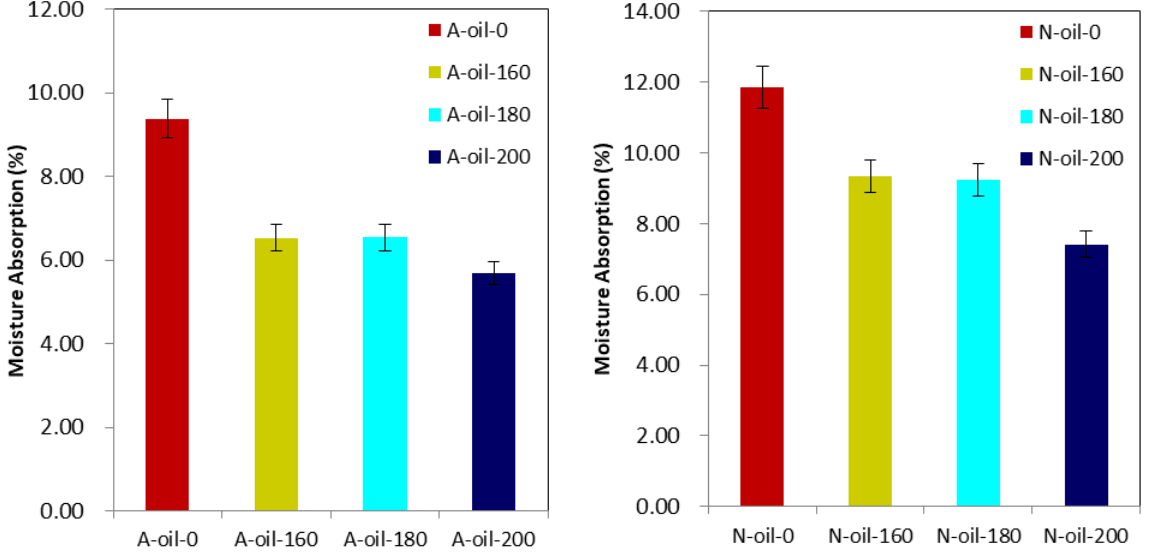
Figure 7. Moisture absorption of Afrormosia and Newtonia heat treated under palm oil.